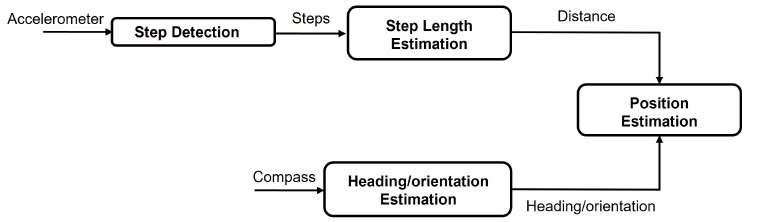
Figure 11. Step and Heading System (SHS), reproduced with permission from Ashraf, Smartphone Sensor Based Indoor Positioning: Current Status, Opportunities, and Future Challenges , published by MDPI,